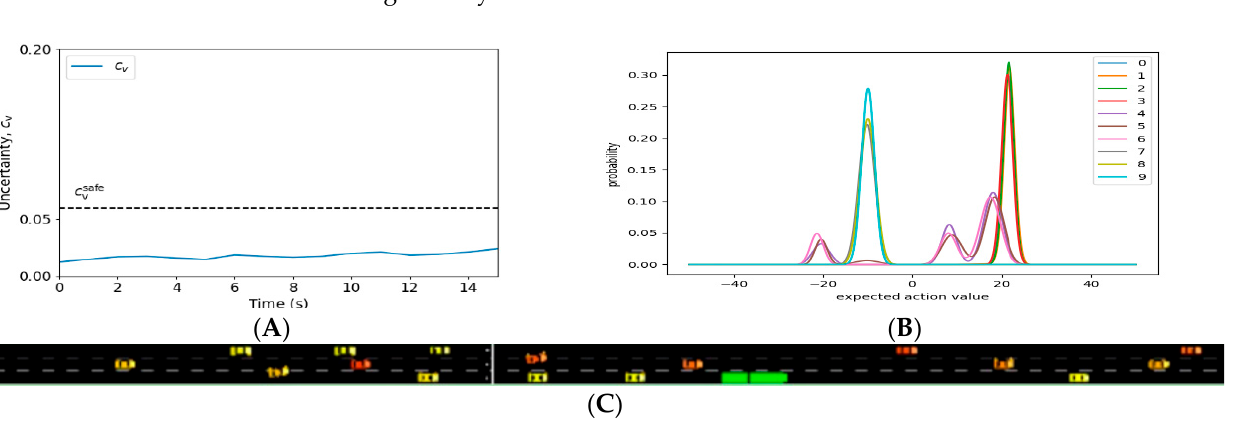
Figure 4. Uncertainty estimation result for normal scenario: ( A ) uncertainty result, ( B ) Gaussian mixture at 6 s, and ( C ) traffic condition display at 6 s.